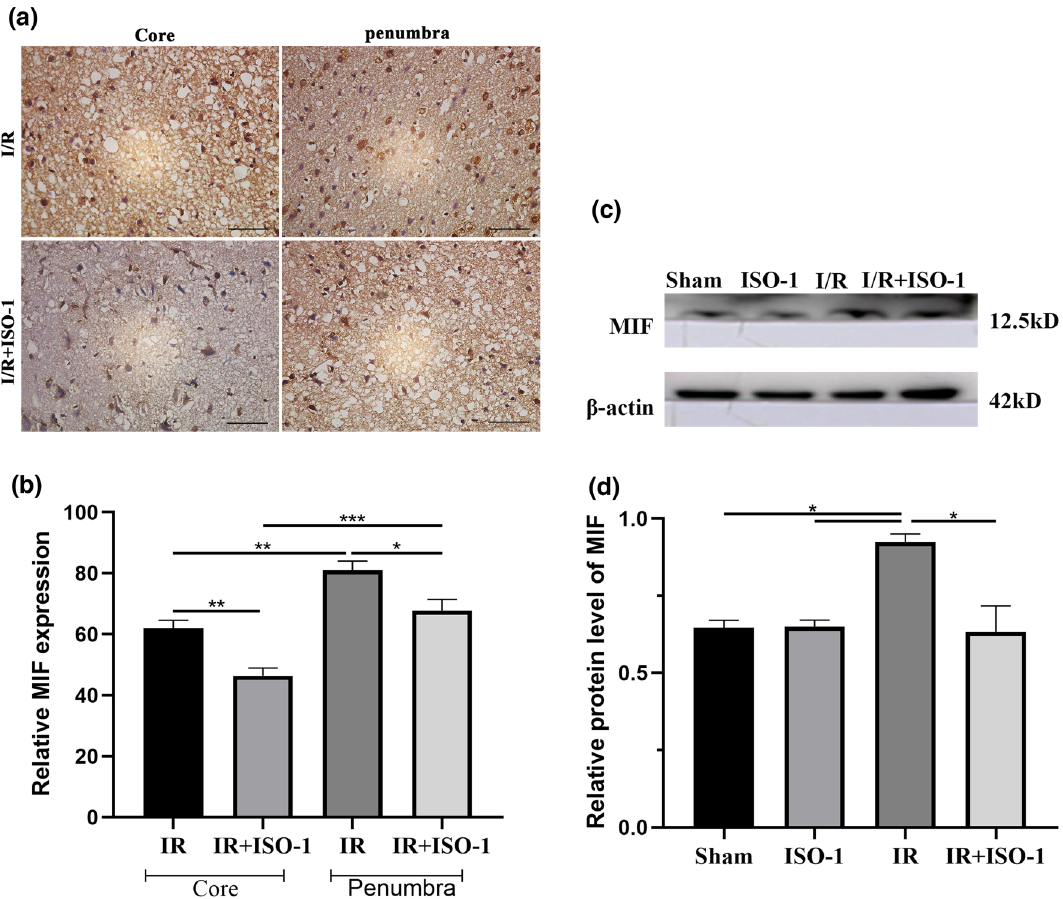
Figure 4. Western blot and immunohistochemistry of the expression of MIF. ( a ) Immunostaining images of MIF in ischemic core and ischemic penumbra in I/R group and I/R + ISO-1 group (bar 50 μm). ( b ) Quantitative analysis of the expression of MIF by immunohistochemistry. ( c ) Western blot images of expression of MIF in peripheral ischemic brain tissue. ( d ) Quantification of MIF expression among the groups. * P < 0.05, ** P < 0.01, *** P <